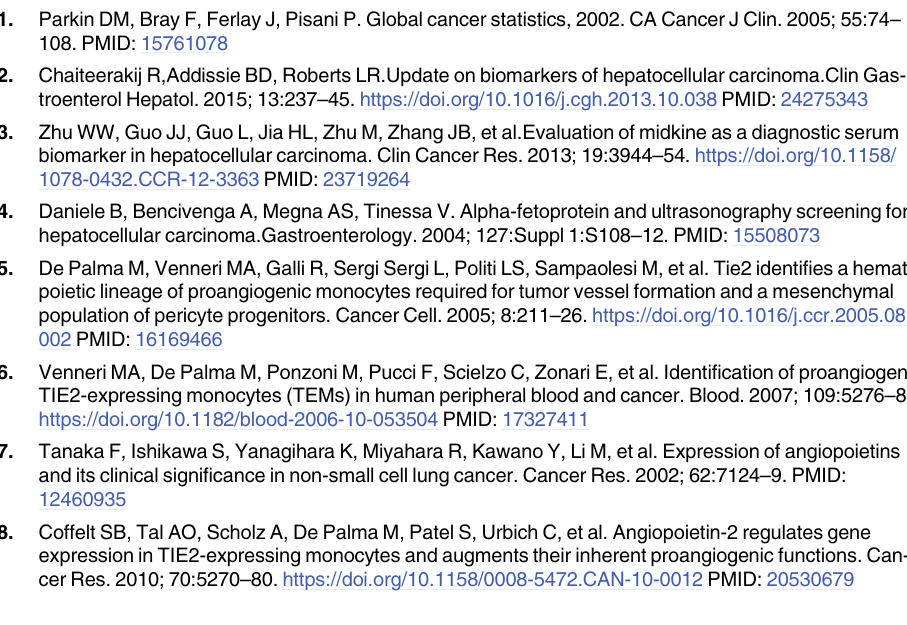
S2 Table. Univariate and multivariate analyses by binary logistic regression to assess the prediction of HCC and AFP-negative HCC from LC